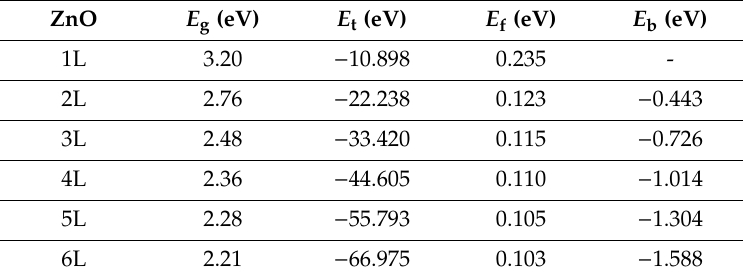
Table 1. Bandgaps, total energies, formation energies, and binding energies of nL ZnO.